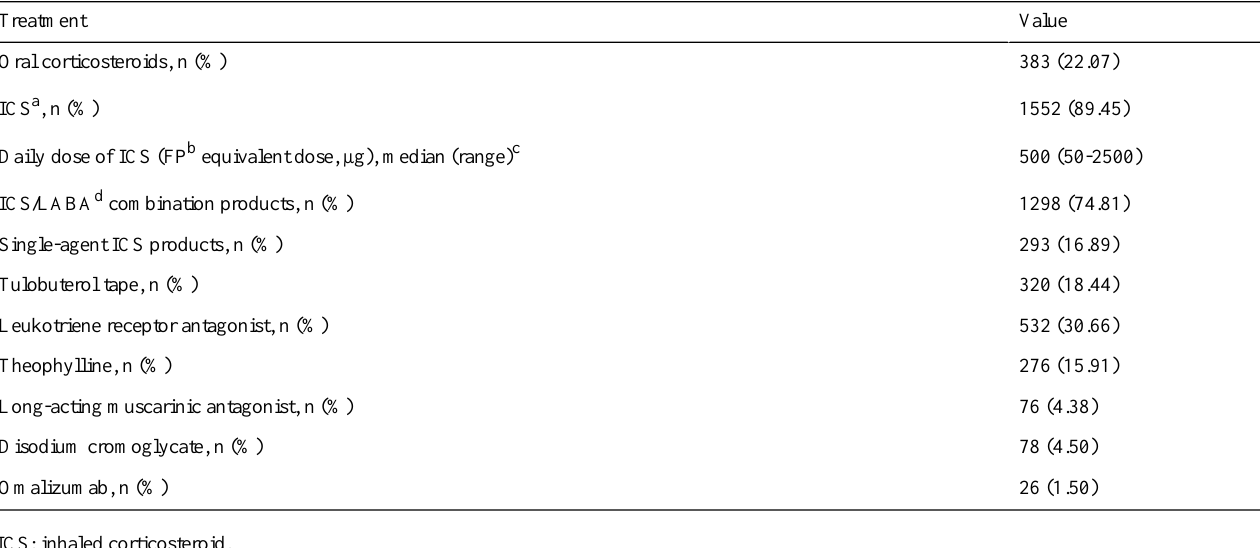
Table 3. Asthma treatments (N=1735).